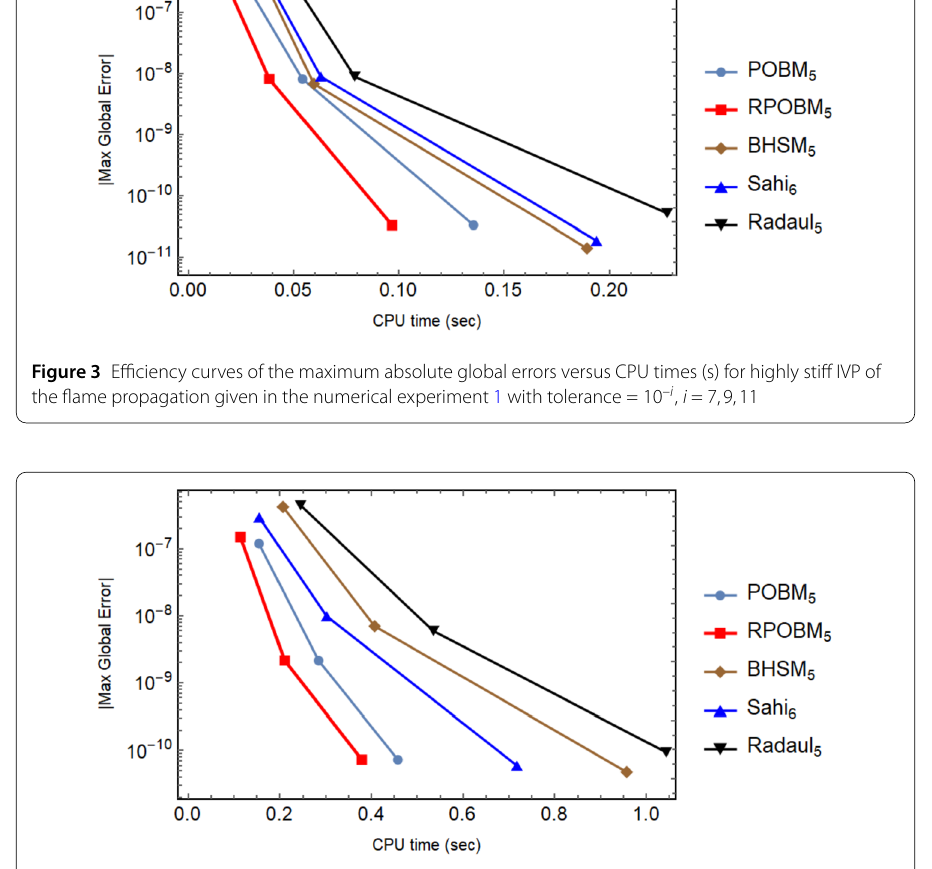
Figure 4 Efficiency curves of the maximum absolute global errors versus CPU times (s) for highly stiff IVP of the flame propagation given in the numerical experiment 1 with tolerance = 10 – i , i = 7,9,11